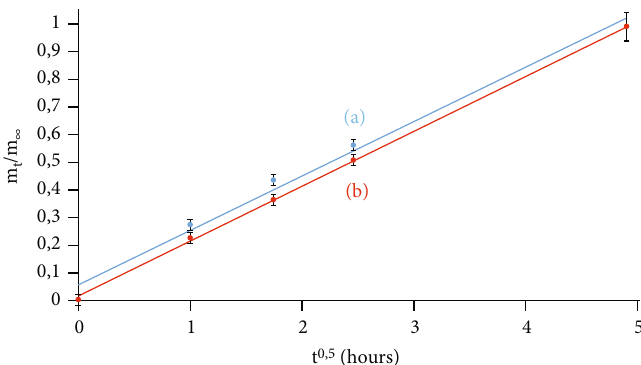
Figure 6: Initial region of the kinetic curve illustrating OZ release from MPs: (a) OZ-MP